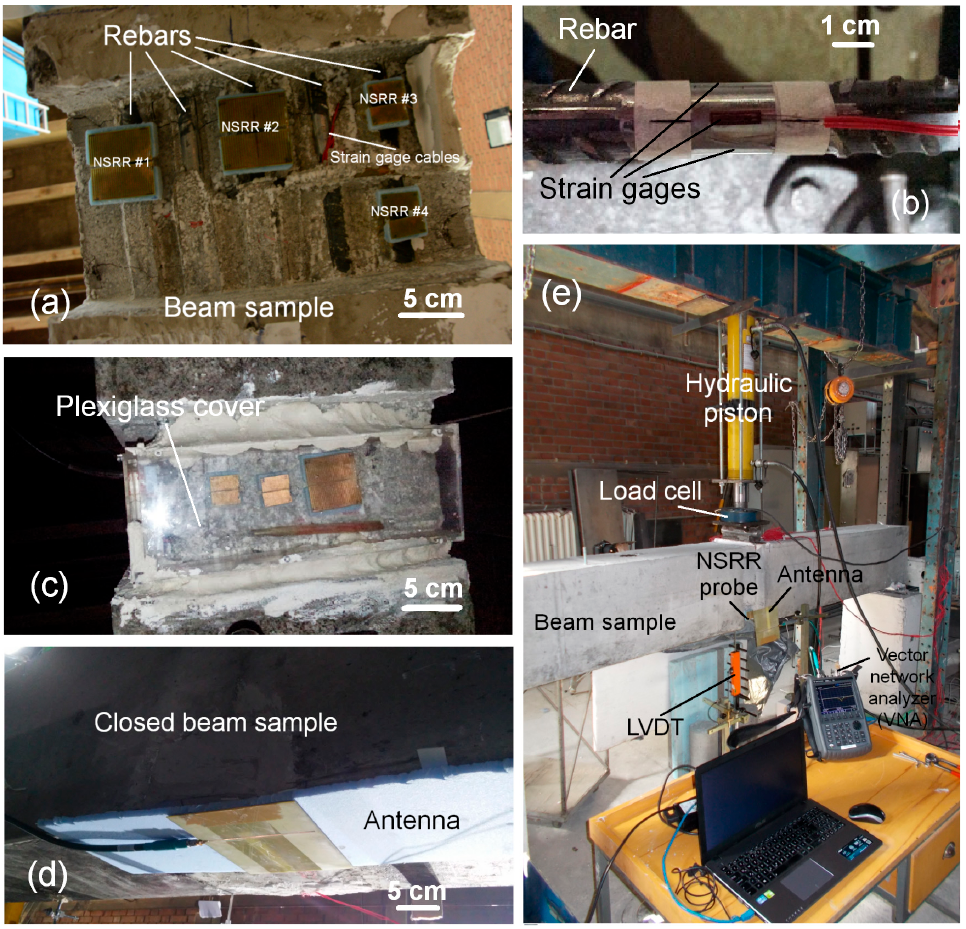
Figure 3. ( a ) The arrangement of the NSRR sensors actually used in the experiment at the bottom of the beam; ( b ) Close-up of a strain gage attached on a rebar before the concrete beam is produced; ( c ) Placement of the protective Plexiglas cover in front of the NSRR sensors (not the actual setup used in the experiment, but from a beam sample used for the preliminary tests before the actual experiment); ( d ) Placement of the antenna at the bottom of the beam, which is closed with a plaster layer after the placement of the sensors and the Plexiglas cover; ( e ) Simply supported beam experiment setup, where the slot antenna and a representative NSRR probe is shown at one side of the beam (the preliminary test setup).